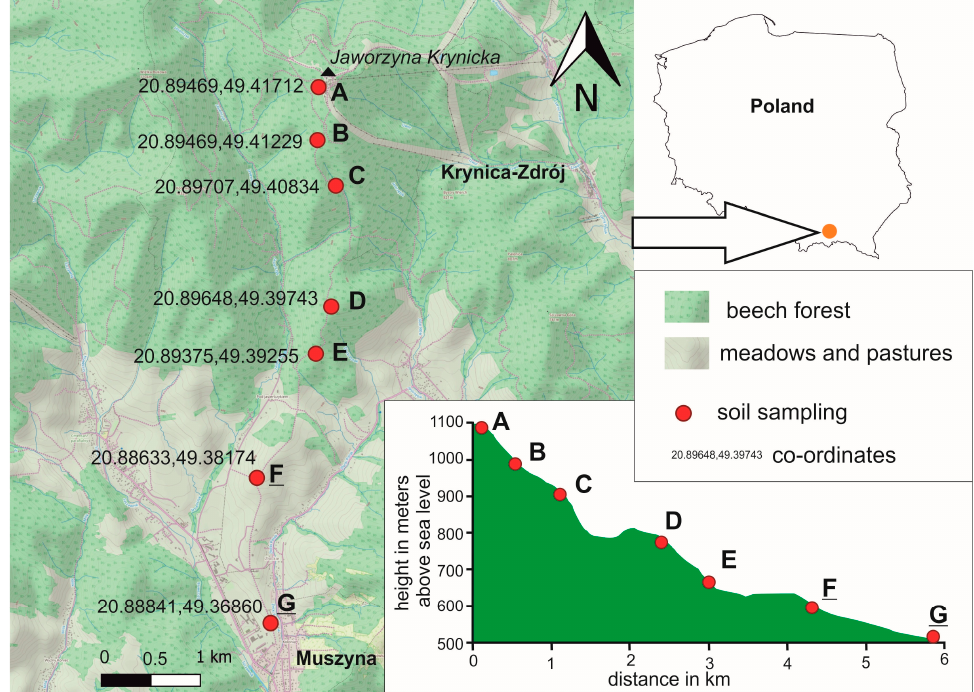
Figure 1. Location of sampling sites.